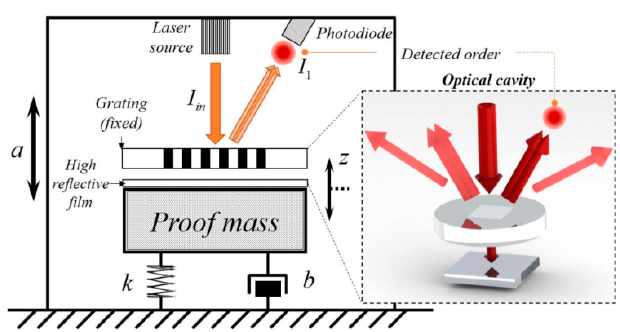
Figure 16. Schematic diagram of the single axis out-of-plane optical MEMS accelerometer developed by Lu et al . at Zhejiang University [77].